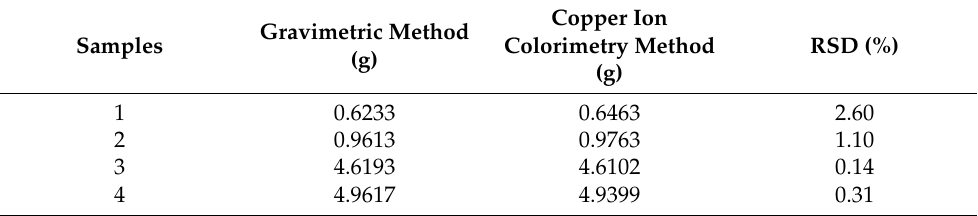
Table 3. Comparison of copper ion colorimetry method and gravimetric method.